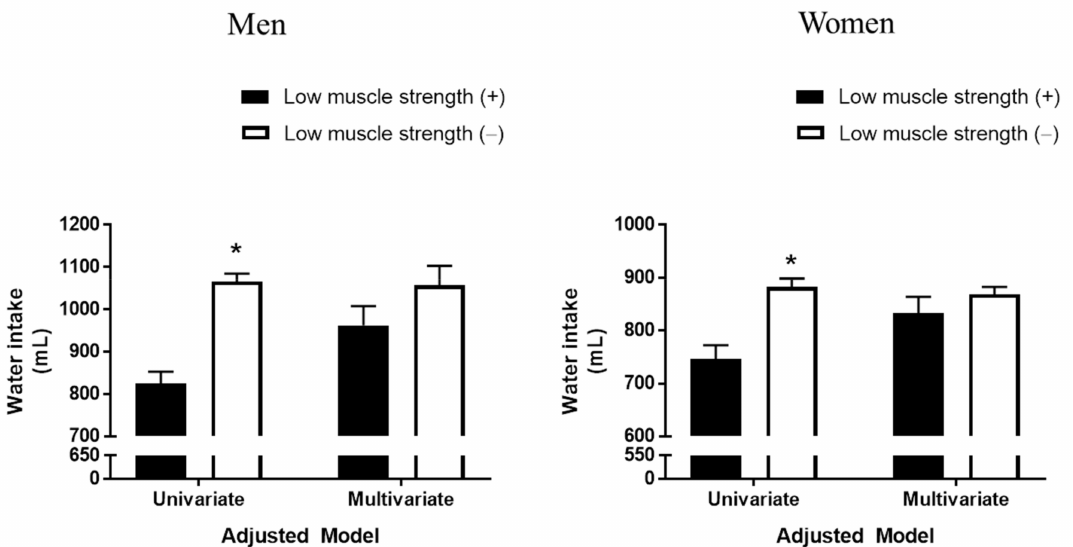
Figure 1. Differences in water intake in men and women with and without low muscle strength before and after adjustment for confounders. Results are expressed as estimated means with 95% confidence intervals based on analysis of covariance. Confounding factors included age, body mass index, smoking status, resistance exercise, heavy alcohol drinking, protein intake, and total energy intake. The cutoffs for hand grip strength defining low muscle strength were 28.6 kg in men and 16.4 kg in women. * Statistically significantly different from subjects with low muscle